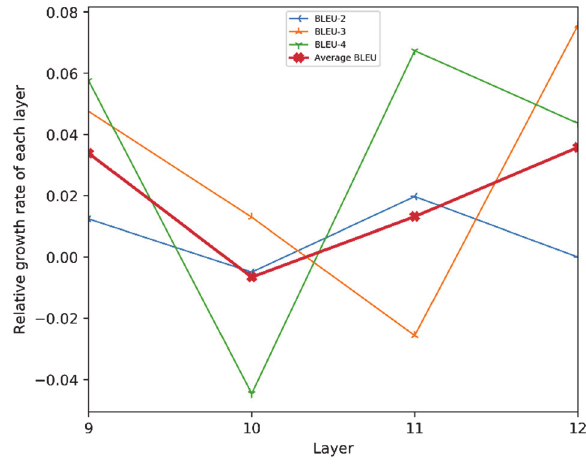
Figure 6. The growth rate of BLEU value varies with the number of network layers. Table 6. BLUE’s evaluation results of fixed